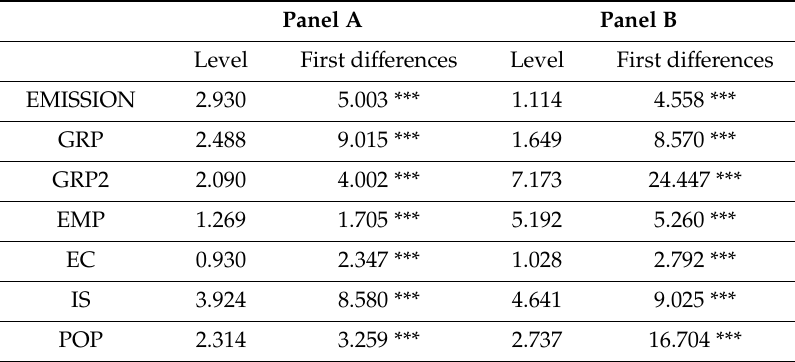
Table A2. Results of Panel Unit Root Test.